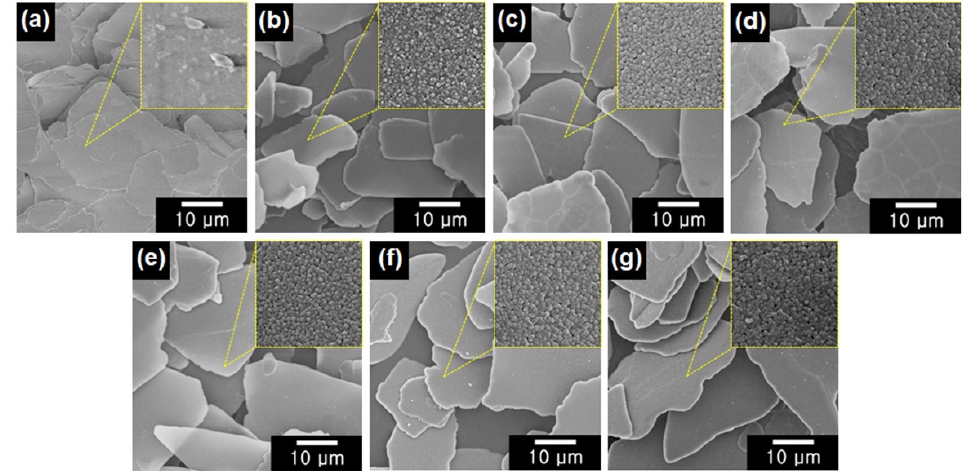
Figure 3. FE-SEM micrographs of ( a ) mica, ( b ) white mica/TiO 2 , ( c ) yellow mica/TiO 2 , ( d ) red mica/TiO 2 , ( e ) violet mica/TiO 2 , ( f ) blue mica/TiO 2 , and ( g ) green mica/TiO 2 (inset: FE-SEM images of the surface of each material).